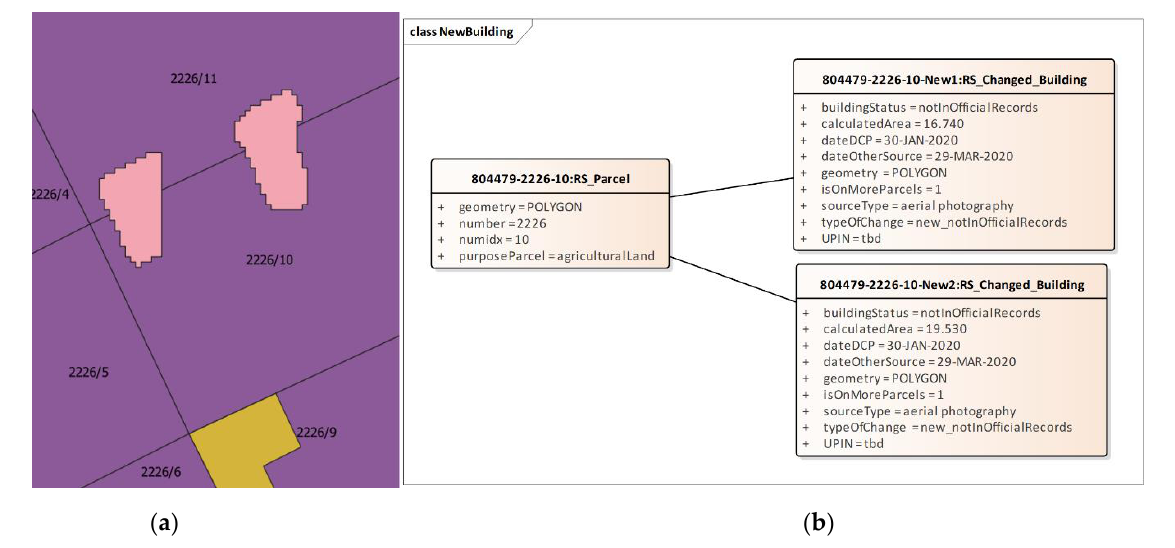
( b ) Figure 28. ( a ) Building in the official records. ( b ) An instance diagram of the detected demolished building. The second case is a situation when the detected data show the existence of new